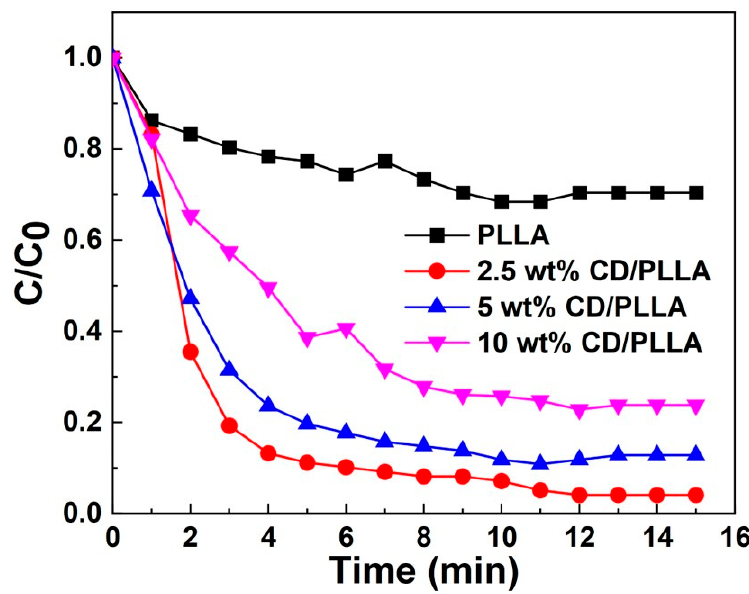
Figure 9. VOC removal efficiency of PLLA and CD/PLLA nanofibers.